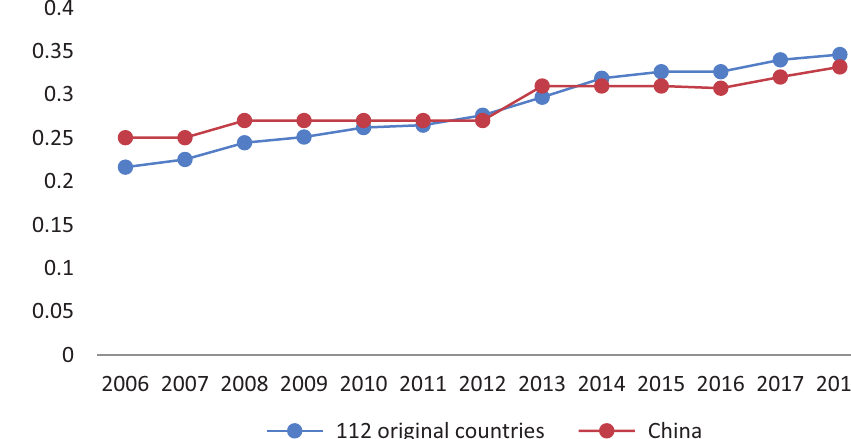
Figure 8. Time series comparison of index in women in parliament. Source: WEF (2006,